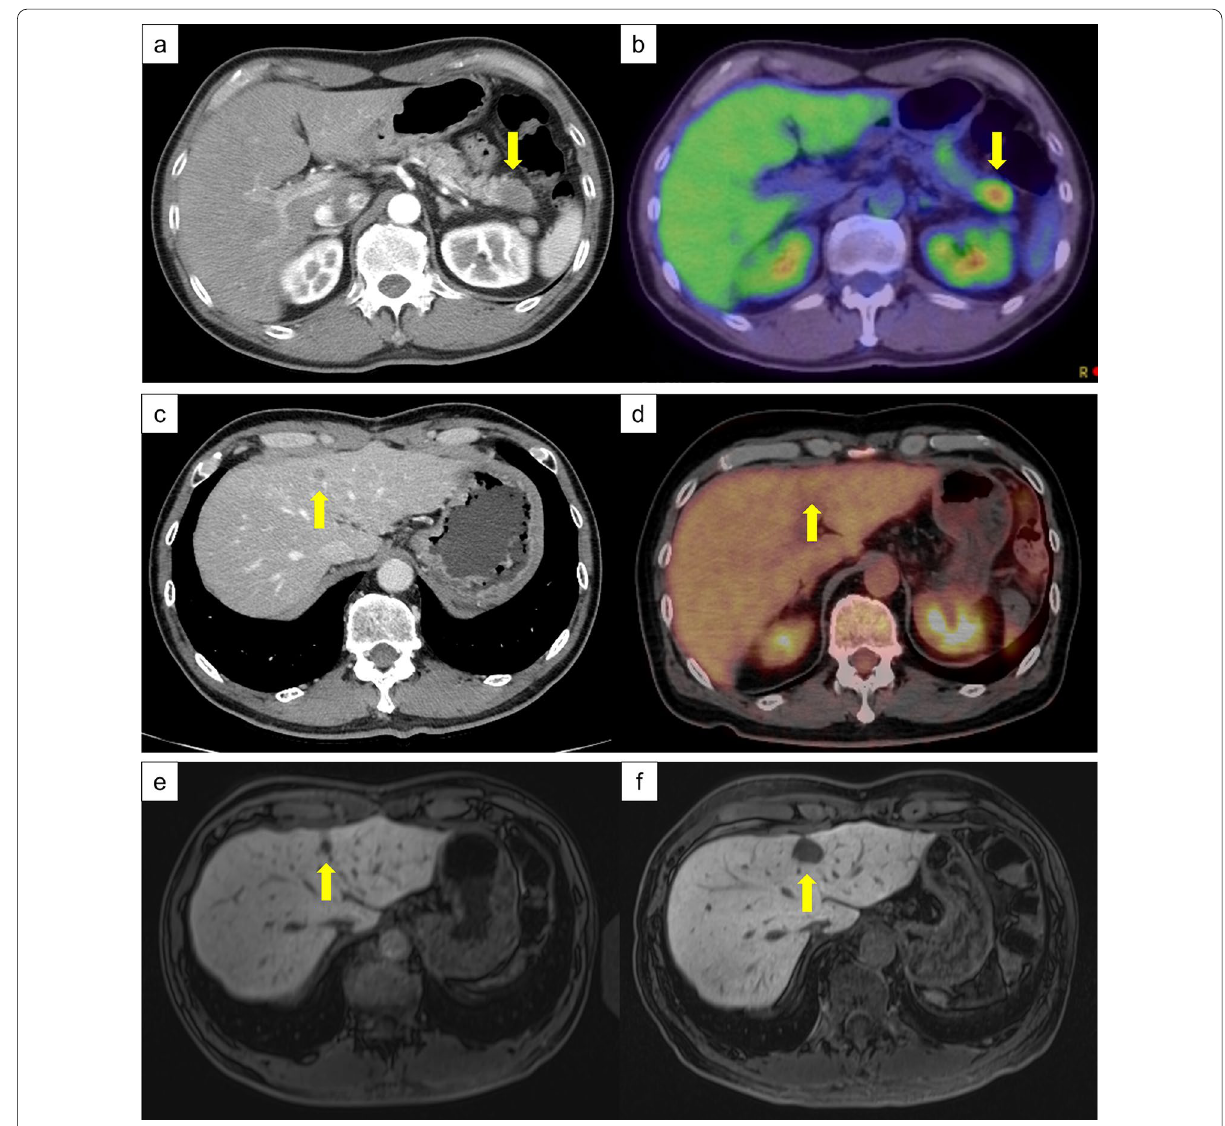
Fig. 1 HYPERLINK "sps:id::fig1||locator::gr1||MediaObject::0" Imaging study for pancreatic cancer and liver metastasis. a Late arterial phase of dCECT revealed a hypovascular lesion at the pancreatic tail. The tumor diameter was 3.0 cm. b Positron emission tomography reveals a high standardized uptake value (maximum 6.6). c Two years after curative pancreatic resection, a small hypovascular liver lesion was identified in segment 4. The tumor diameter was 1.2 cm. d Positron emission tomography at the diagnosis of liver metastasis reveals a standardized uptake value of 3.3, which was equivalent to normal liver parenchyma. e , f Change that occurred from before to after chemotherapy for liver metastasis. Although the tumor diameter increased to 2.5 cm, the number of tumors did not change. dCECT dynamic contrast-enhanced computed